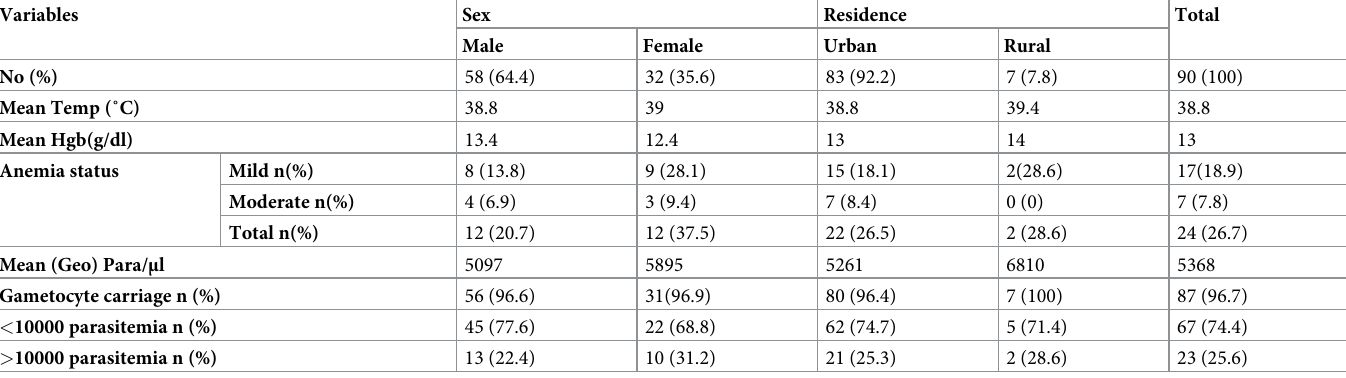
Geo = Geometric, Hgb = Haemoglobin, Para = Parasitaemia, Temp =